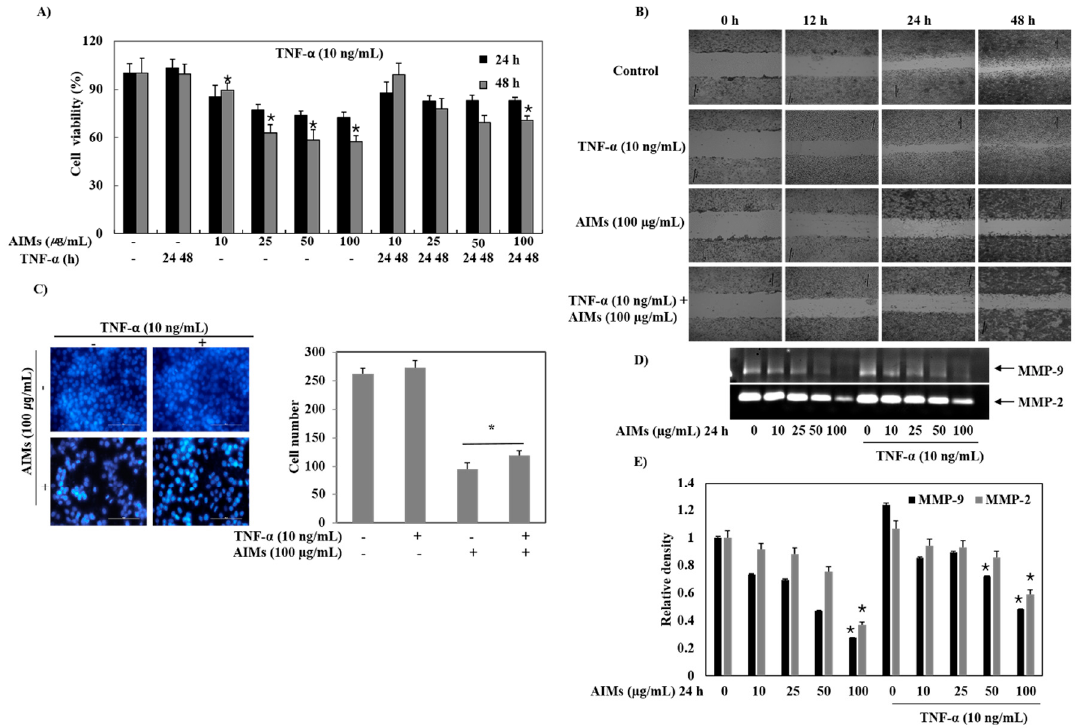
Figure 1. Anti-cancer effects of anthocyanins isolated from Vitis coignetiae Pulliat (AIMs) on Hep3B hepatocellular carcinoma cells. Hep3B cells were seeded at a density of 5 × 10 4 cells/mL. The cells were treated with indicated concentrations of AIMs for the indicated times. ( A ) Cell viability assay. AIMs induced anti-proliferative effects in a dose-dependent manner. In the TNF- α treatment, the anti-proliferative effects of AIMs were diminished. ( B ) Wound healing assay. Hep3B cells showed the dose-dependent inhibition of migration at different time points. ( C ) DAPI (4 ′ ,6-diamidino-2-phenylindole) staining. The graphical representation depicts that AIMs inhibited the TNF- α stimulated invasion in Hep3B cells. ( D ) Gelatin zymography. The MMP-2 and MMP-9 activities were suppressed by AIMs in the presence of TNF- α stimulation. (E ) Densitometry analysis of MMP-9 and MMP-2 gelatin zymography.The data are shown as the means ± SD of three independent experiments, * p < 0.05 between the treated and the untreated control group.